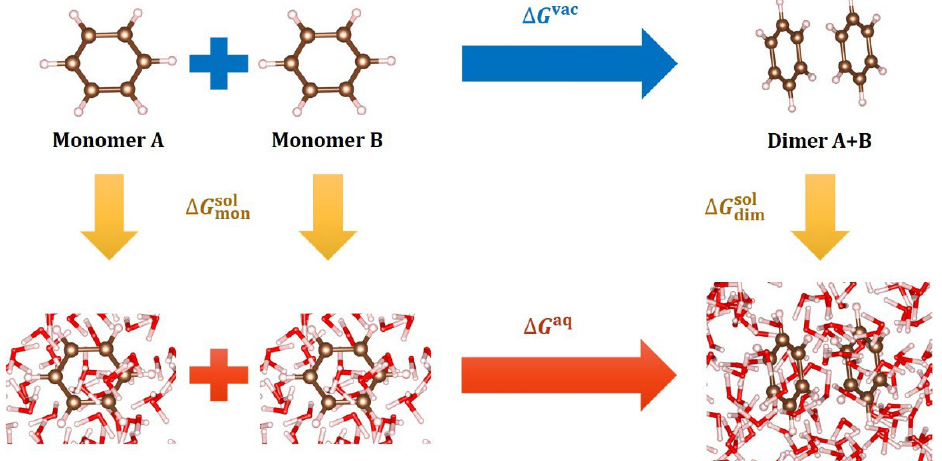
– interaction in aqueous solution. The free Figure 1. Thermodynamic cycle describing aromatic Figure 1. Thermodynamic cycle describing aromatic π – π interaction in aqueous solution. The energy of association in water ( ) can be calculated using the free energy of association in vac- free energy of association in water ( ∆ G aq ) can be calculated using the free energy of association in 𝜋𝜋 𝜋𝜋 ) and the solvation free energy difference ( ) between a dimer ( ) and two uum ( aq vacuum ( ∆ G vac ) and the solvation free energy difference ( ∆∆ G sol ) between a dimer ( ∆ G sol ) and two ∆𝐺𝐺 monomers ( ). Different colors indicate different atom types: white—hydrogen; brown— dim dimsol vac sol ∆∆𝐺𝐺 ∆𝐺𝐺 ∆𝐺𝐺 monomers ( ∆ G sol mon ). Different colors indicate different atom types: white—hydrogen; brown—carbon; carbon; and red—oxygen (same for the following figures). monsol ∆𝐺𝐺 and red—oxygen (same for the following figures).